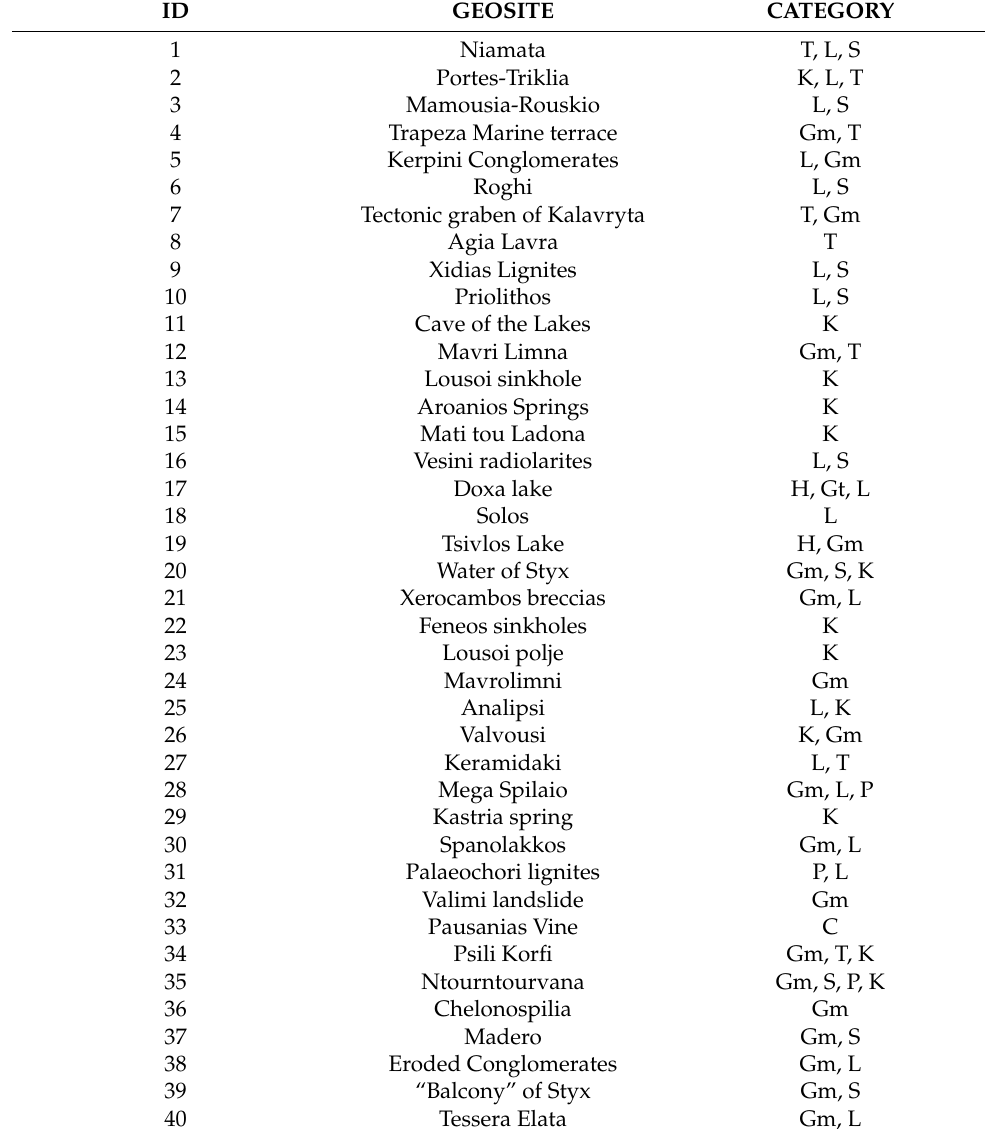
Table 1. The geosites of Chelmos-Vouraikos UGGp and their categories. Tectonic (T), Lithological (L), Stratigraphical (S), Karstic (K), Geomorphological (Gm), Hydrological (H), Geotechnical (Gt), Palaeontological (P), Cultural